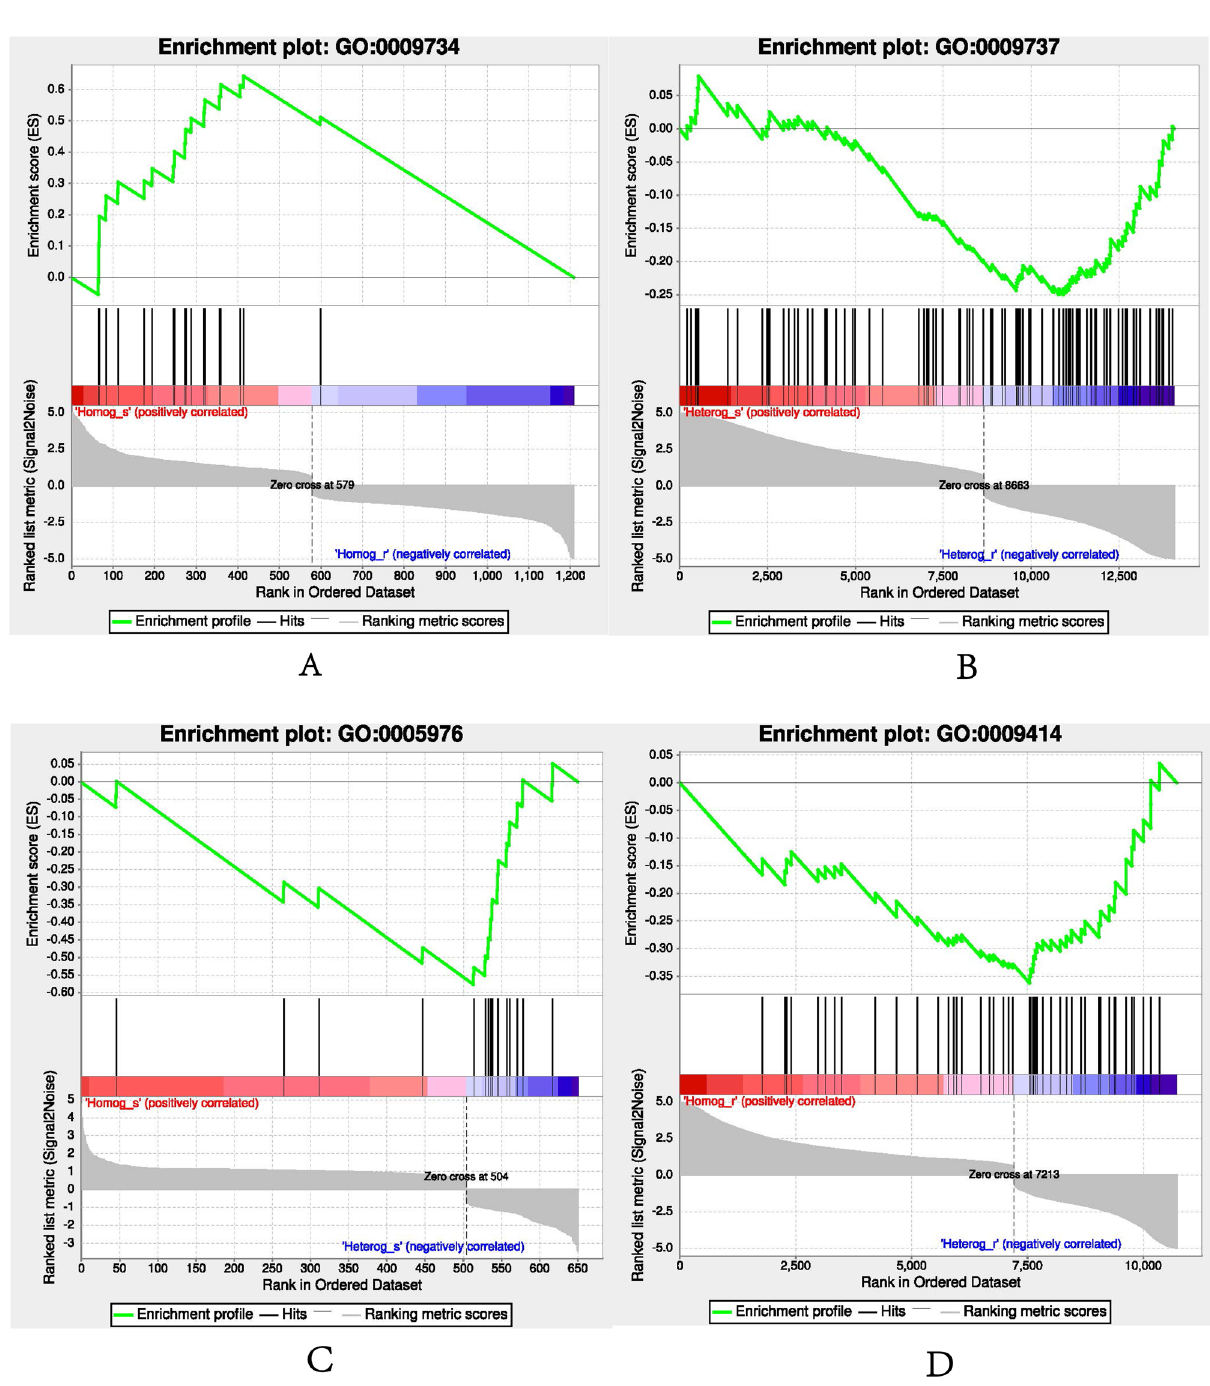
Figure 7. GSEA analysis of different grafting groups, ( A ) auxin-activated signaling pathway (GO:0009734) between Homog_s and Homog_r, ( B ) response to abscisic acid (GO:0009737) between Heterg_s and Heterg_r, ( C ) polysaccharide metabolic process (GO:0005976) between Homog_s and Heterg_s, ( D ) response to water deprivation (GO:0009414) between Homog_r and